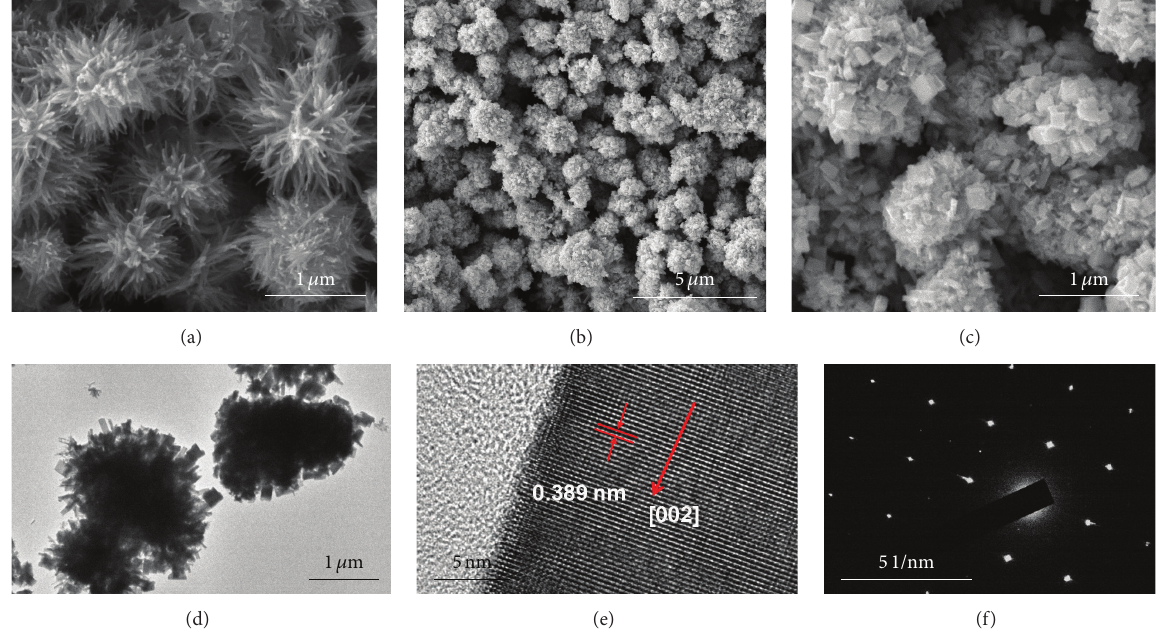
Figure 2: SEM images of Cu-doped tungsten oxide samples calcined at different temperatures. (a) SEM image of urchin-like Cu-doped W 18 O 49 at 300 ∘ C. (b) SEM image of flower-like Cu-doped WO 3 at 600 ∘ C. (c) High-magnification image of (b). (d) TEM image of flower-like Cu-doped WO 3 at 600 ∘ C. (e) High-resolution TEM (HRTEM) image of the flower-like sample. (f) Selected area electron diffraction (SAED) pattern of the sample in